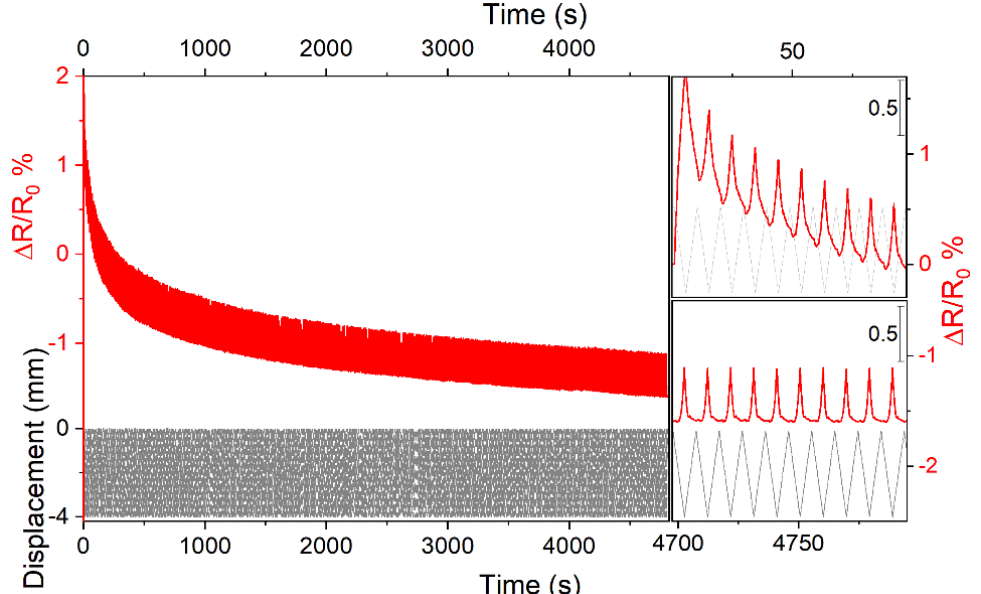
Figure 10. ∆ R/R 0 duration test (red line) for 500 loading/unloading cycles (black line) using a cycling speed of 50 mm/s for a displacement of 4 mm. The ∆ R/R 0 variation in the first and last 10 loading/unloading cycles is shown in the top and bottom insets,